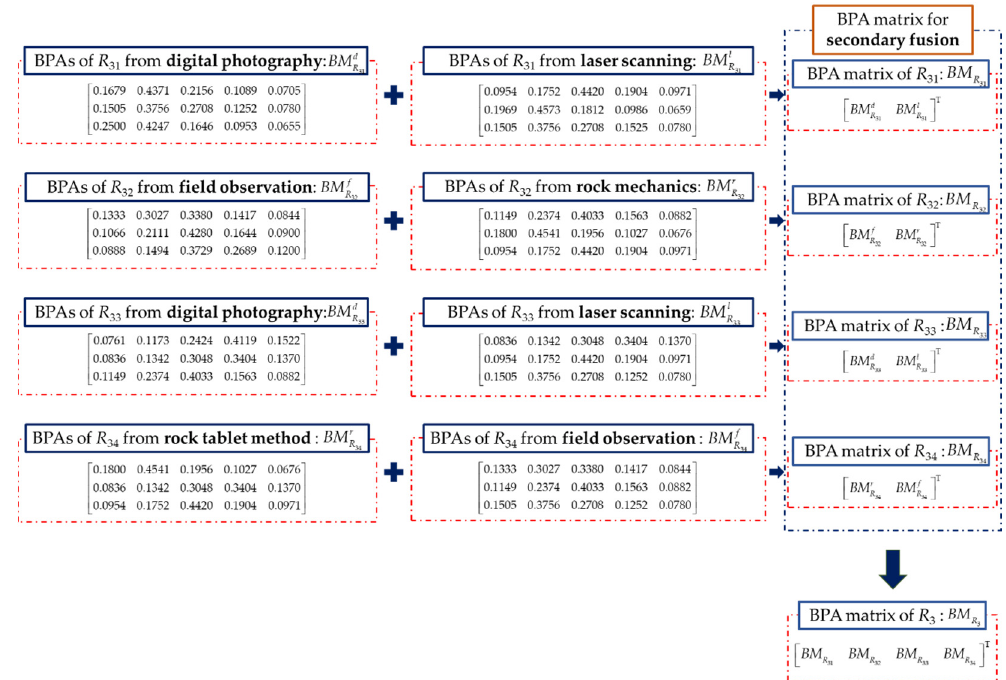
(26) Rock mass index R 3 is rated by the condition of discontinuities. The sub-indicators of R 3 are considered, including the rating of continuity, the rating of roughness, the rating of infilling, and the rating of weathering. The data of discontinuities of the rock mass are collected and rated, which is used to construct 3 R BM in Figure 10. The continuity and the infilling of the rock mass is measured by digital photography and laser scanning based on the point load model [47]. The roughness of the rock mass is obtained by field observation and rock roughness coefficient based on rock mechanics [48]. The weather- ing condition of the rock mass is obtained by the field observation and rock tablet method